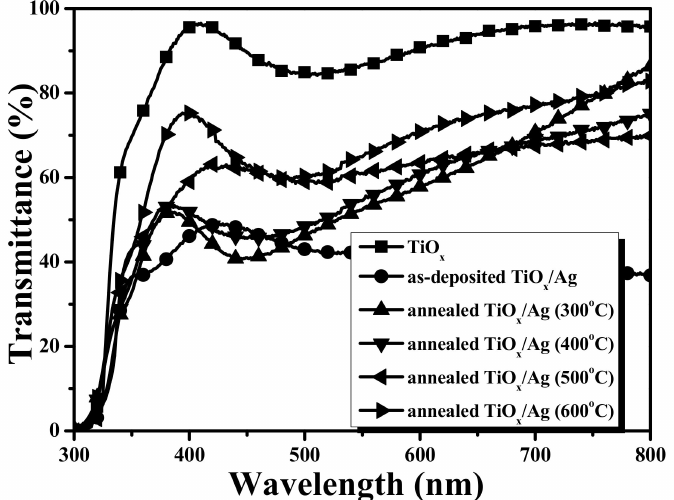
Figure 6. Optical transmittance of the as-deposited and annealed TiO x /Ag structures (optical trans- mittance of the TiO x film also is shown as a